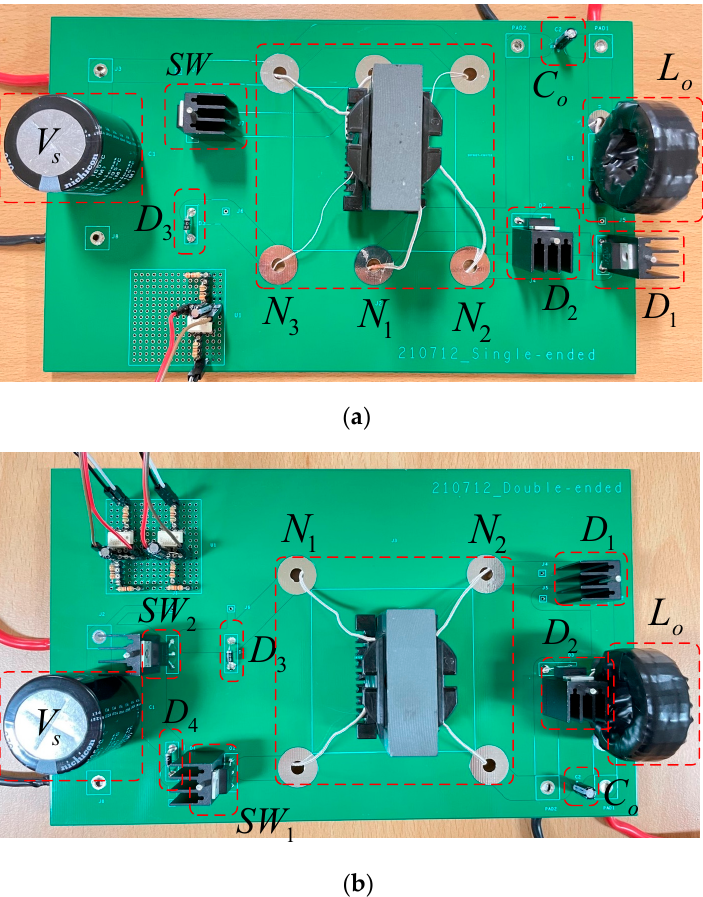
Figure 13. Cost comparison of forward converters.